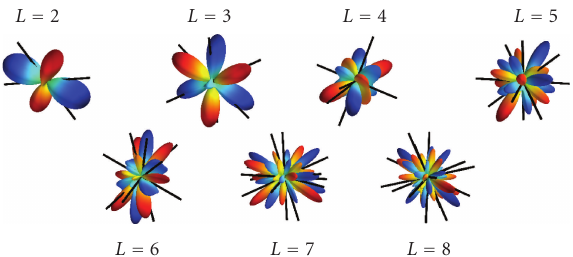
Figure 3: Multipole vectors of our sky, based on WMAP five-year full-sky ILC map and with galactic plane coinciding with the plane of the page. The temperature pattern at each multipole (cid:2) (2 ≤ (cid:2) ≤ 8) can either be described by an angular temperature pattern (colored lobes in this figure), or alternatively by precisely (cid:2) multipole vectors (black “sticks”). While the multipole vectors contain all information about the directionality of the CMB temperature pattern, they are not simply related to the hot and cold spots and, for example, do not correspond to the temperature minima/maxima [14]. Notice that (cid:2) = 2 and 3 temperature patterns are rather planar with the same plane and that their vectors lie approximately in this plane. Adopted from [15].